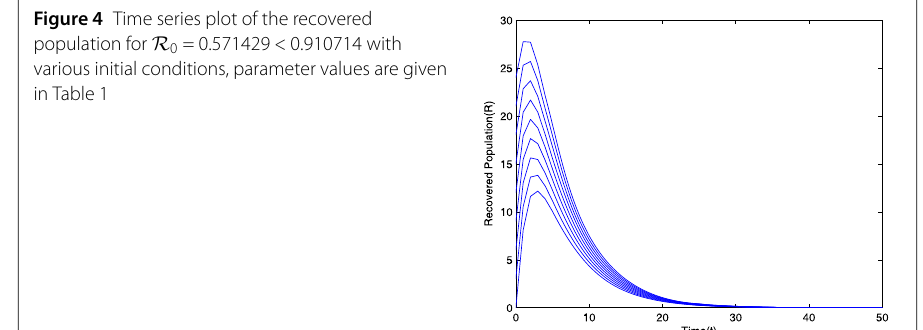
Figure 5 Time series plot of the vaccinated population for R 0 = 0.571429 < 0.910714 with various initial conditions, parameter values are given in Table 1